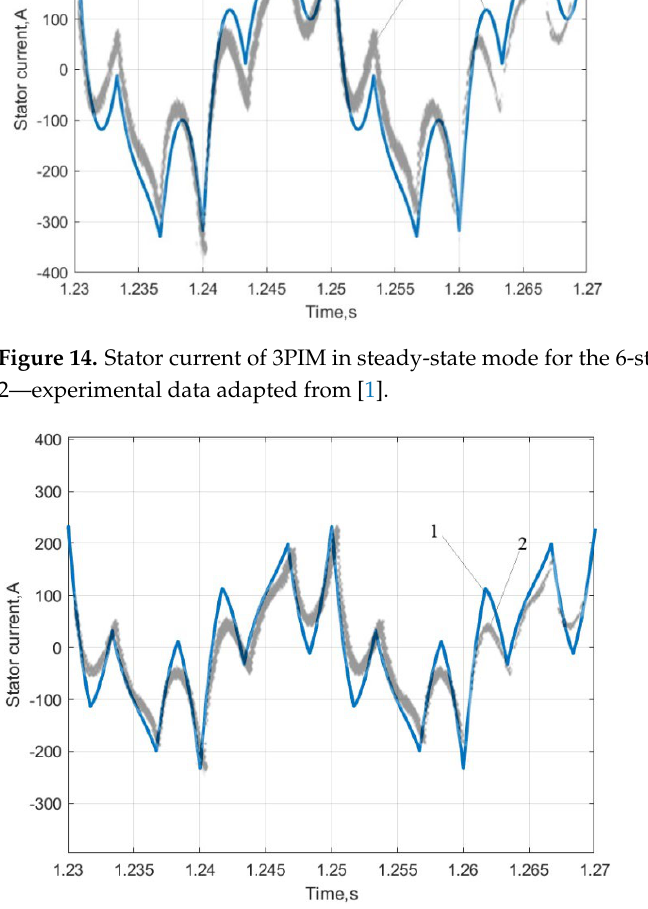
Figure 15. Stator current of asymmetric 6PIM in steady-state mode for the 6-step VSI supplying: 1—simulation, 2—experimental data adapted from [1].